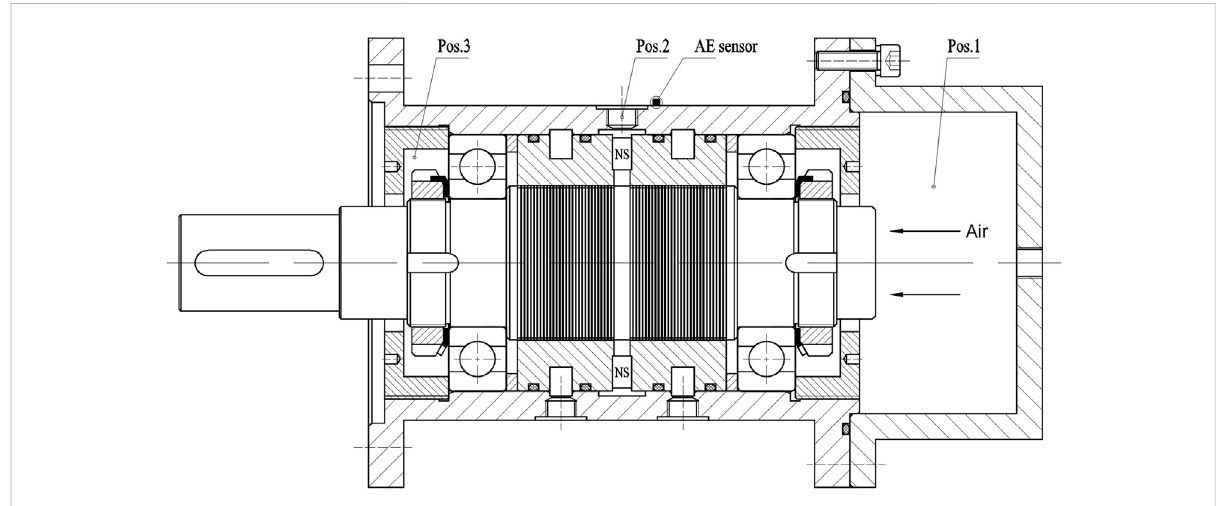
FIGURE 2 Structure of the multi-stage seal used in the research.